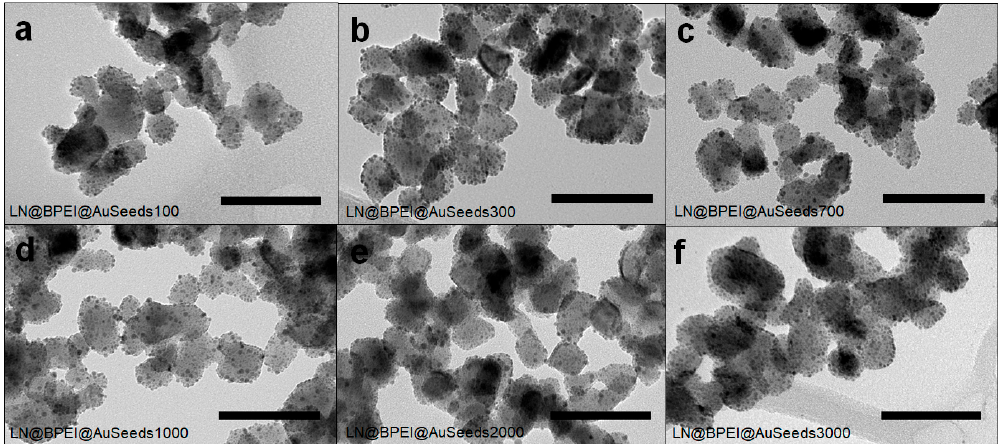
Figure 2. TEM images of gold seeds attached to LN NPs, at different gold seed loading densities. ( a ) LN@BPEI@AuScheme 100. ( b ) LN@BPEI@AuSeeds300, ( c ) LN@BPEI@AuSeeds700, ( d ) LN@BPEI@AuSeeds1000, ( e ) LN@BPEI@AuSeeds2000 and ( f ) LN@BPEI@AuSeeds3000. Scale bar corresponds to 100 nm.